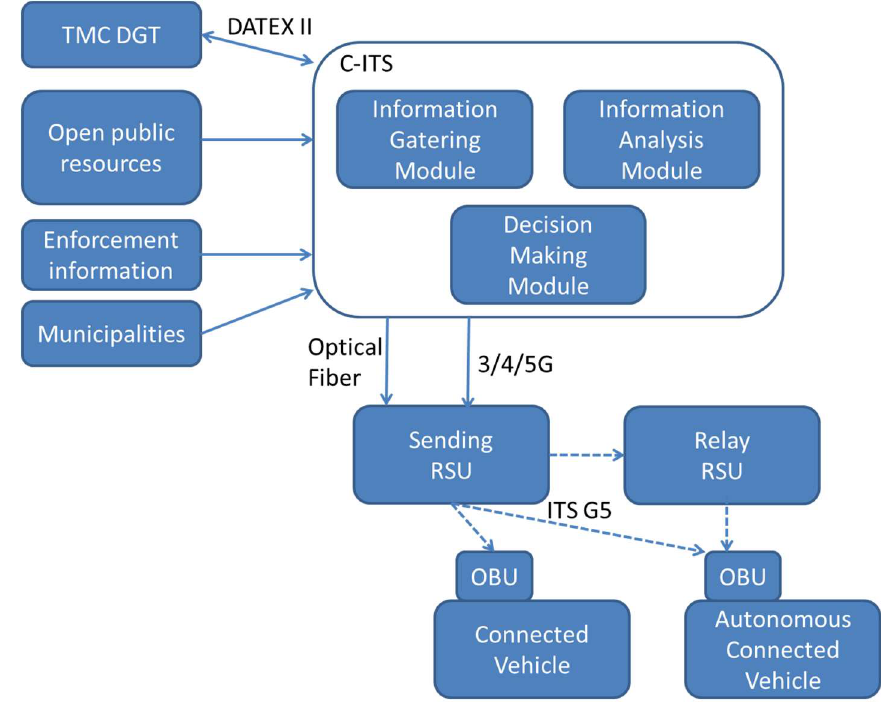
Figure 1. C-ITS functional architecture.